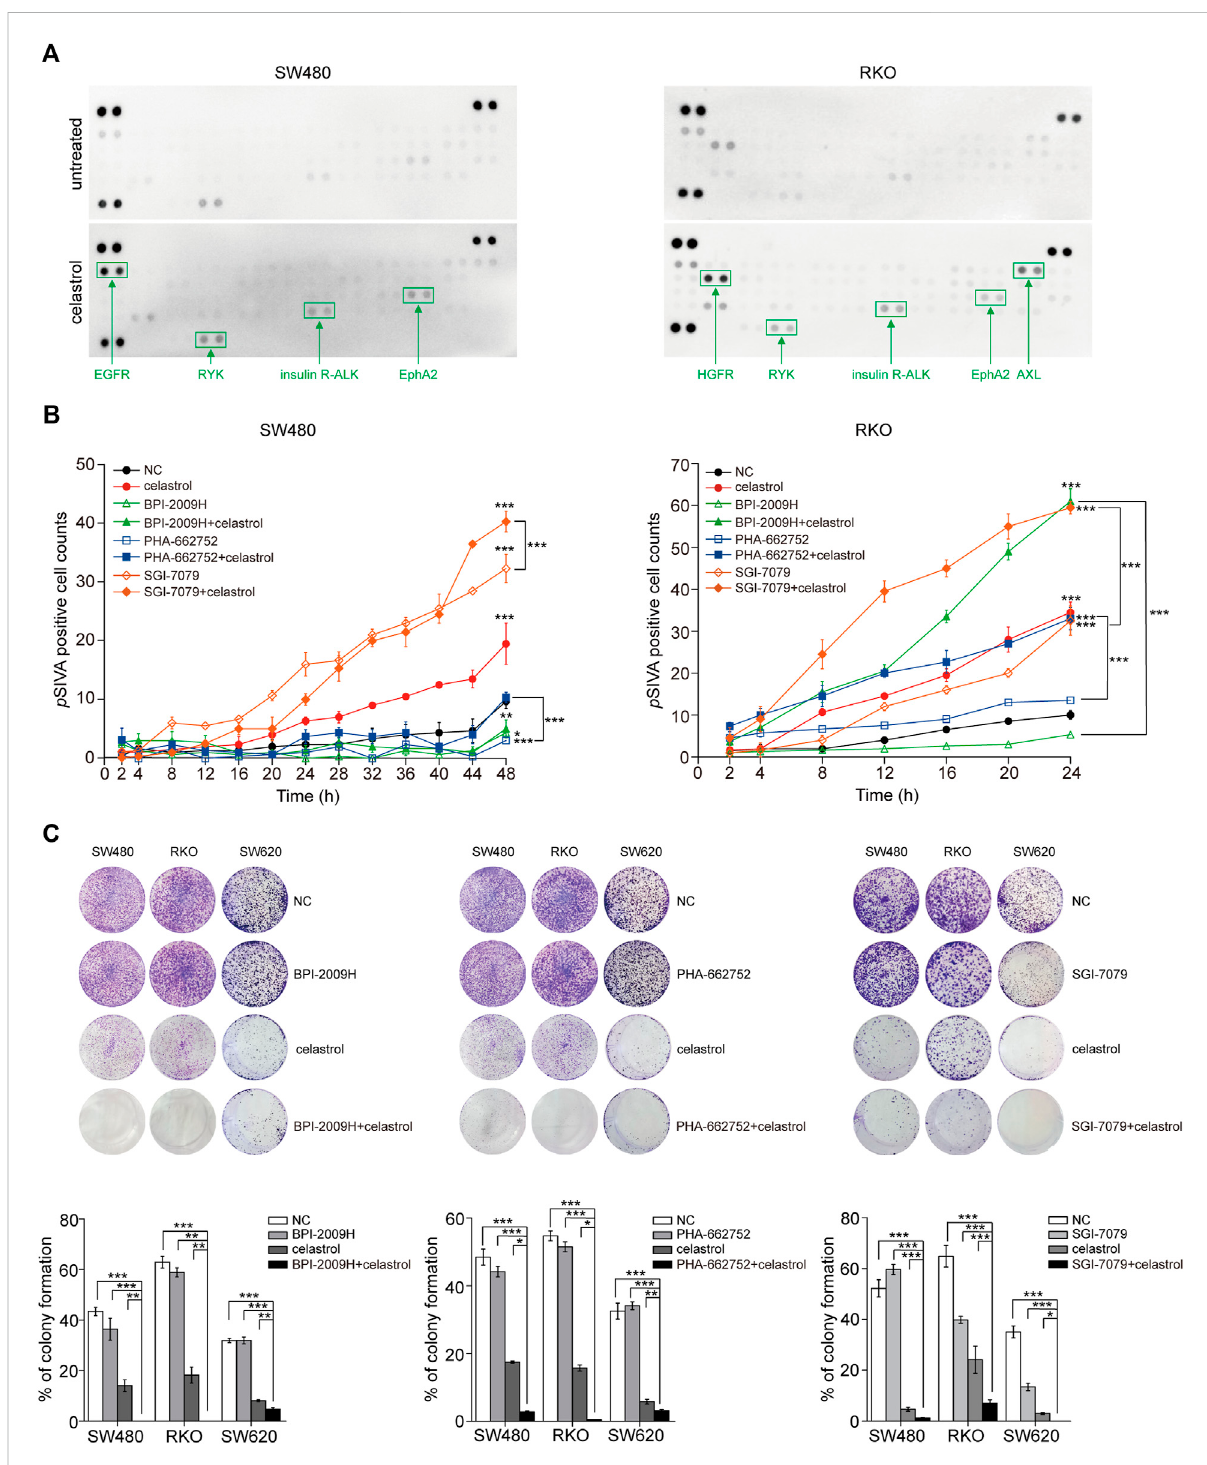
FIGURE 2 Reactivation of RTKs results in limited inhibitory effect of low-dose celastrol on CRC cells. (A) Activation of RTKs in CRC cells treated with 0.25 μ M celastrol for 1 h. (B) p SIVA real-time apoptosis assay of CRC cells after the treatments of celastrol alone, RTK inhibitors alone, or their combination. (C) Colonyformation assay ofCRC cells receivedthe treatment of celastrol alone, RTKinhibitor alone, ortheir combination.* p < 0.05; ** p < 0.01; *** p <